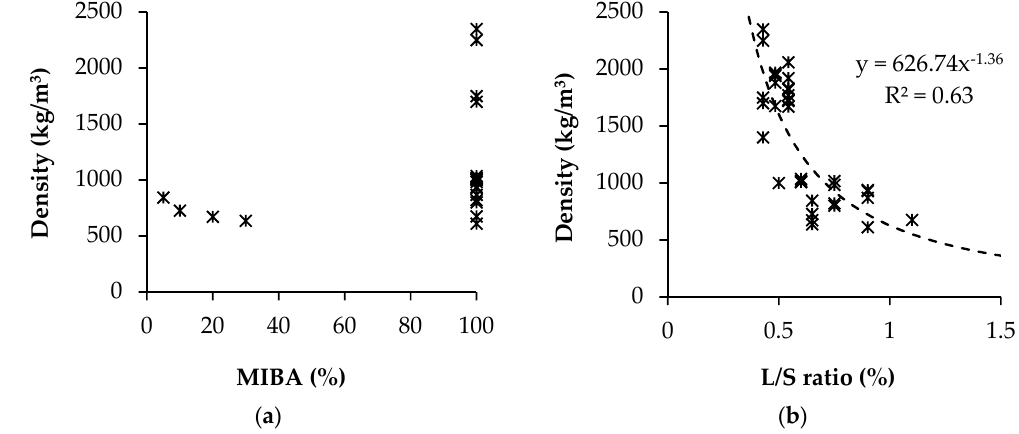
Figure 7. Density of AAM vs. ( a ) MIBA incorporation ratio and ( b ) liquid to solid ratio.